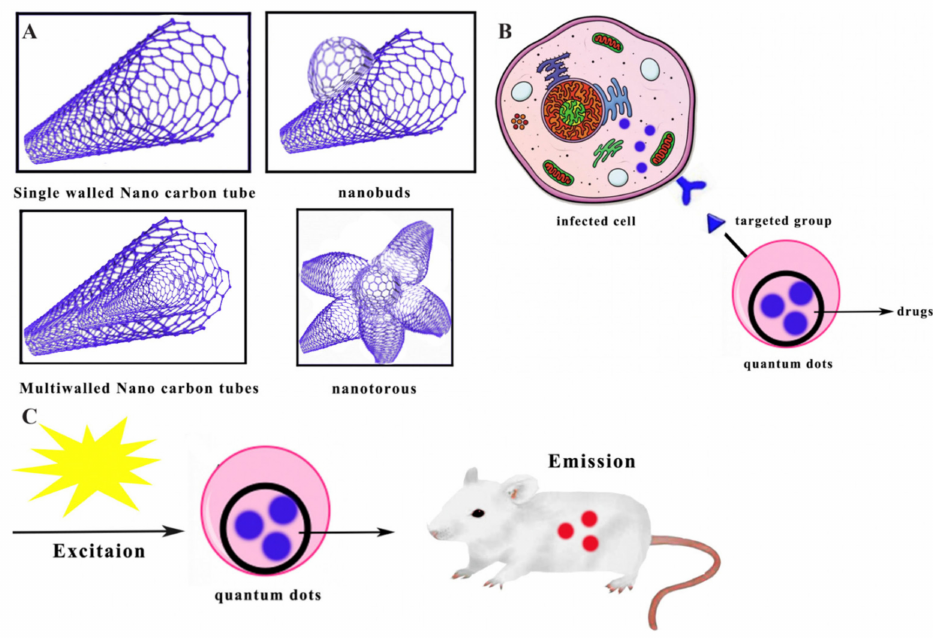
Figure 9. ( A ) Shapes of carbon nanotubes. ( B ) Schematic in vivo targeting for diagnostic or therapeutic purposes of quantum dots, adapted from [182]. ( C ) Schematic bioluminescence imaging process of quantum dots, adapted from